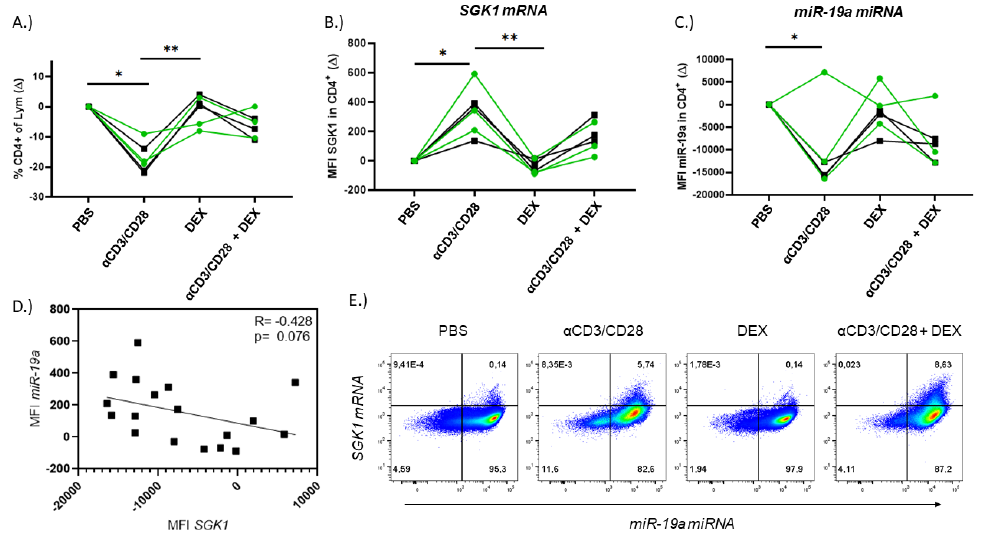
Figure 3. T cell activation causes opposing expression patterns of miR-19a and SGK1 in CD4+ T cells. PBMCs were isolated from whole blood and treated for 48 h with α CD3 α CD28 ( α CD3/CD28), dex- amethasone (DEX), α CD3 α CD28 and dexamethasone ( α CD3/CD28 + DEX) or medium alone (PBS) before performing PrimeFlow ® RNA Assay. ( A ) Percentage of lymphocytes that are CD4+. The in- tensity of SGK1 mRNA (MFI) in CD4+ T cells ( B ). The intensity of miR-19a (MFI) in CD4+ cells ( C ). Correlation of MFI SGK1 and MFI miR-19a in CD4+ T cells under treated conditions ( D ). Repre- sentative flow cytometry plot showing miR-19a and SGK1 mRNA for each condition ( E ). A green line indicates an individual with asthma and black line indicates a healthy individual (n = 6). Ex- pression is presented as a change from PBS control. MFI = median fluorescent intensity. Significance was determined by Friedman ANOVA. * = p < 0.05; ** = p < 0.01. Furthermore, the expression of SGK1 and miR-19a was visualized in CD4+ T cells that were sorted and stained using the PrimeFlow protocol. As in the PrimeFlow RNA assay, we observed increased expression of SGK1 mRNA under α CD3/ α CD28 stimulation and the combined conditions compared to Dex treatment (Figures 4 and S3A). As in flow cytometry, nearly every cell expressed miR-19a (red), but not every cell expressed SGK1 (green) (Figures 3E and S4B,C).